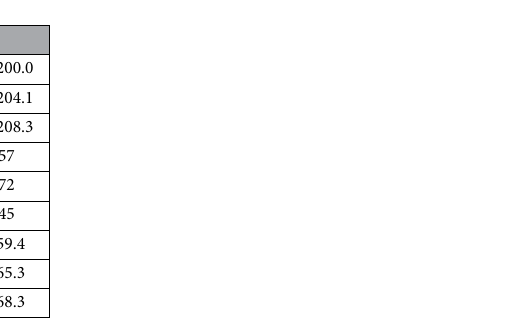
Figure 8. The equilibrium isotherm ( a ) and the isotherm models of Langmuir ( b ), Freundlich ( c ), and Dubinin–Radushkevich ( d ) for the adsorption of CR by the prepared nanocomposites.